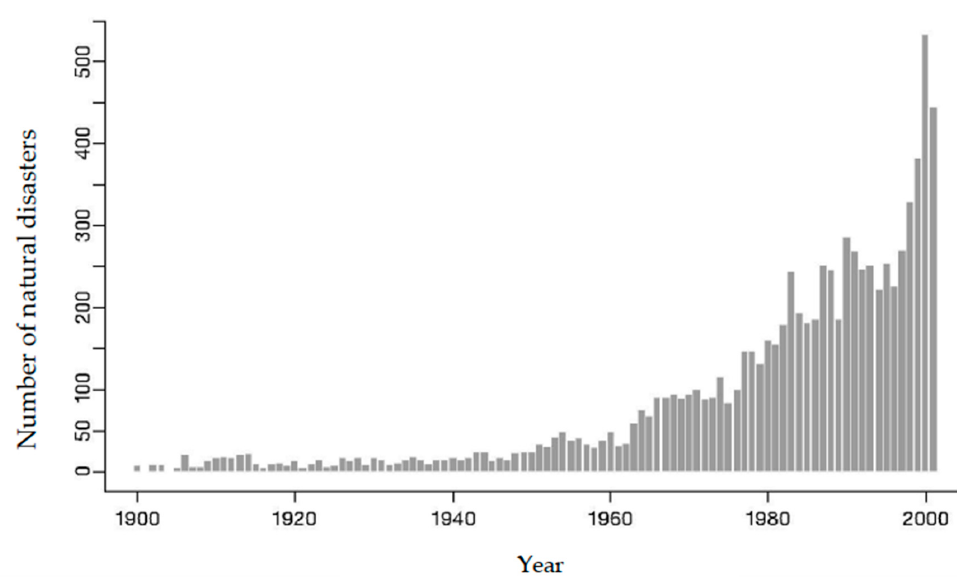
Figure 1. Number of natural disasters in Europe in 1900–2002 [15].